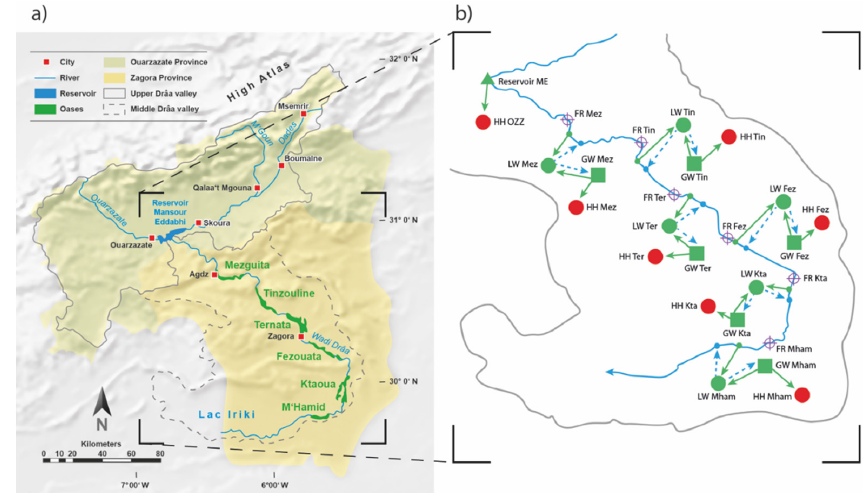
Figure 1. ( a ) Drâa catchment in an administrative context showing the city of Ouarzazate, the reservoir Mansour Eddahbi and the order of oases along the Wadi Drâa (modified from [24]); ( b ) WEAP structure as used in this study (GW: groundwater; FR: river network link; HH: domestic water use; LW: agricultural water use; blue arrow: river; green arrow: water transmissions to demand sites; dashed blue arrows: runoff or backflow). dashed blue arrows: runoff or